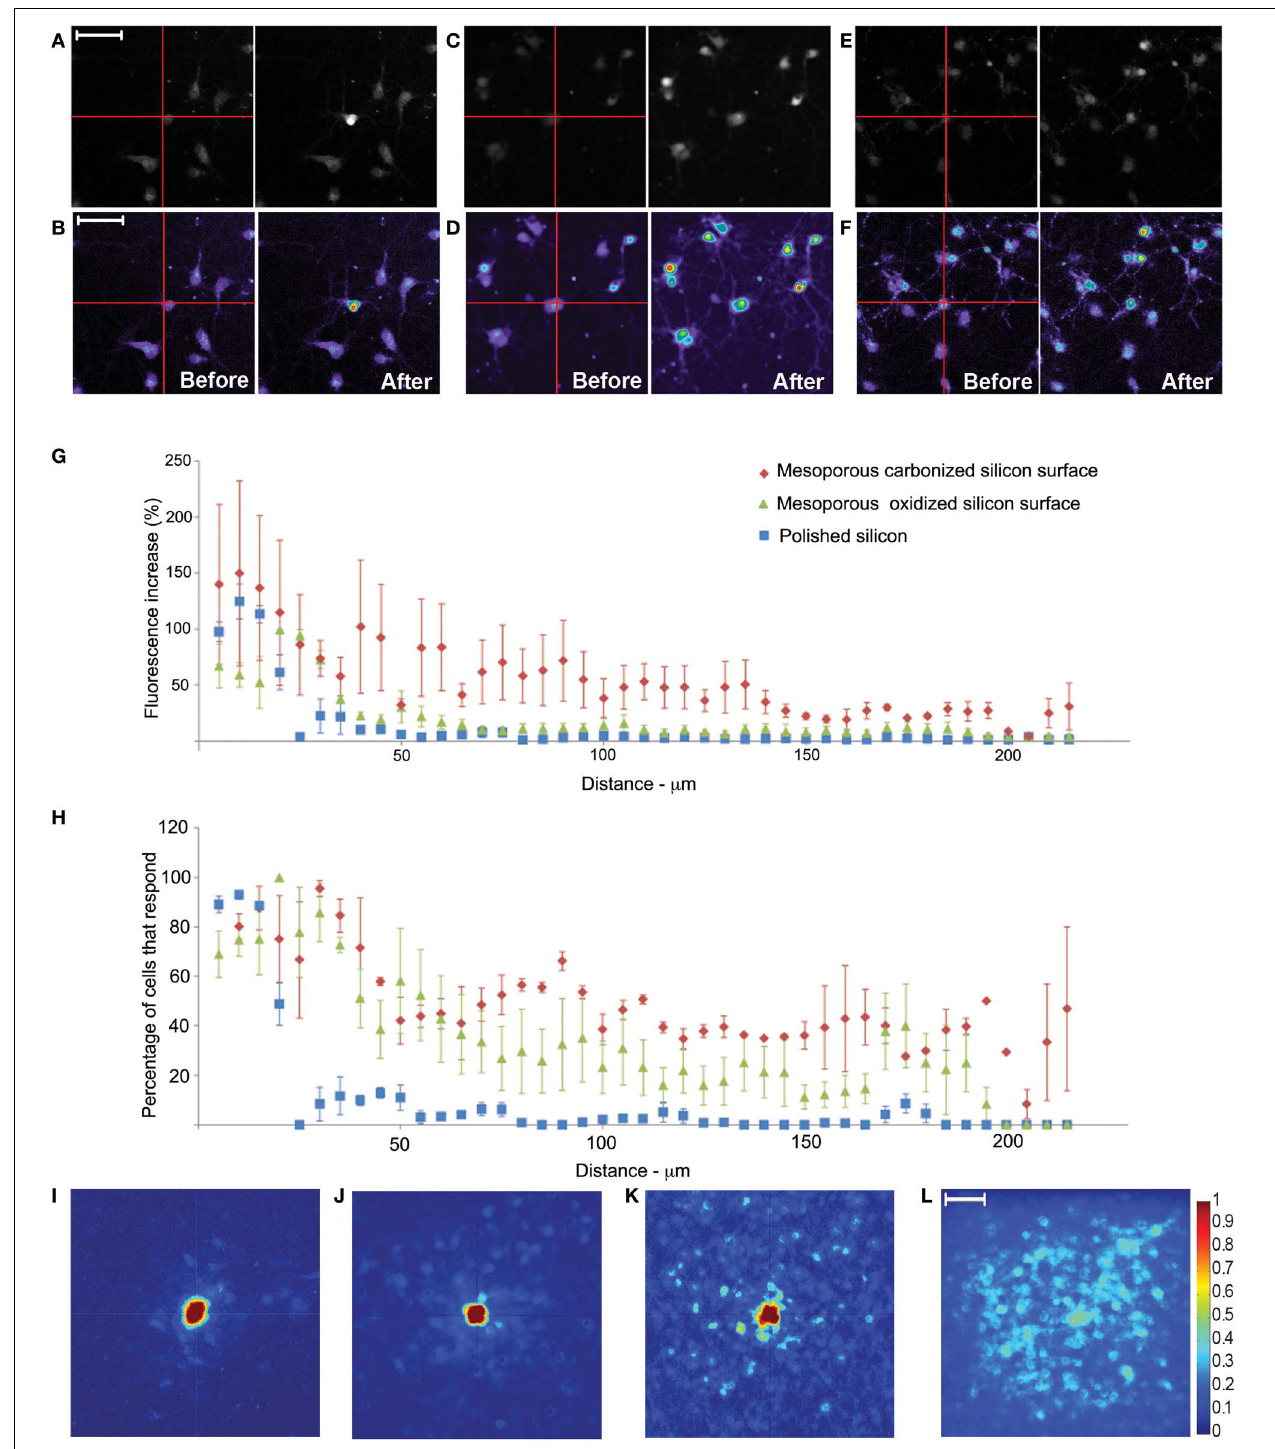
FIGURE 5 | Spatial resolution of photoconductive stimulation of rat primary cortical neurons on three different substrates. Representative set of images showing targeted neuronal excitation visualized by Fluo-4 calcium imaging of neurons cultured on (A,B) polished silicon, (C,D) porous oxidized silicon or (E,F) porous carbonized silicon. (G) Fluorescence increase as a function of distance to stimulation point and (H) percentage of cells activated